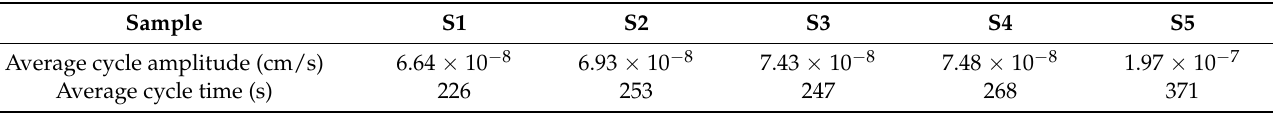
Table 2. Cyclic variation characteristics of permeability coefficients of different soil